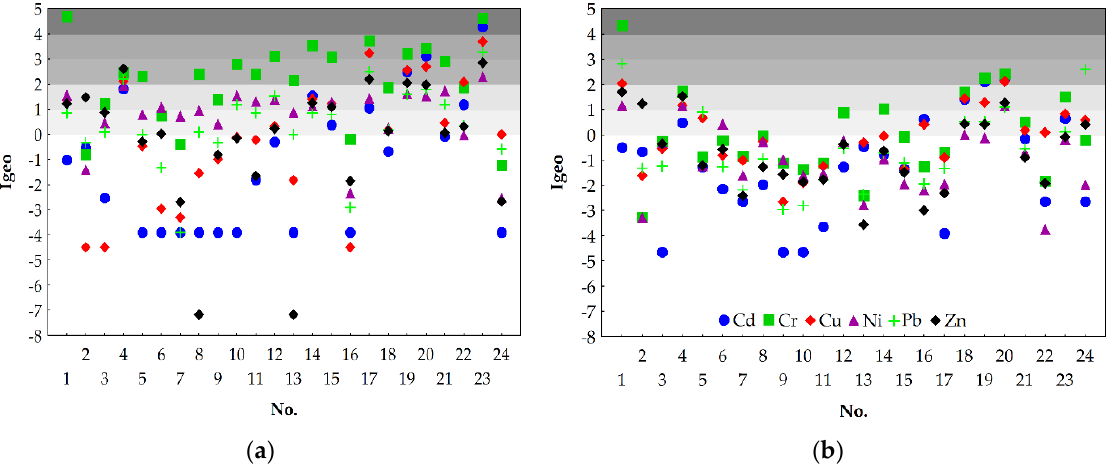
Figure 5. Geoaccumulation Index (Igeo) in bottom sediments of the Warta River in 2016 ( a ) and 2017 ( b ).